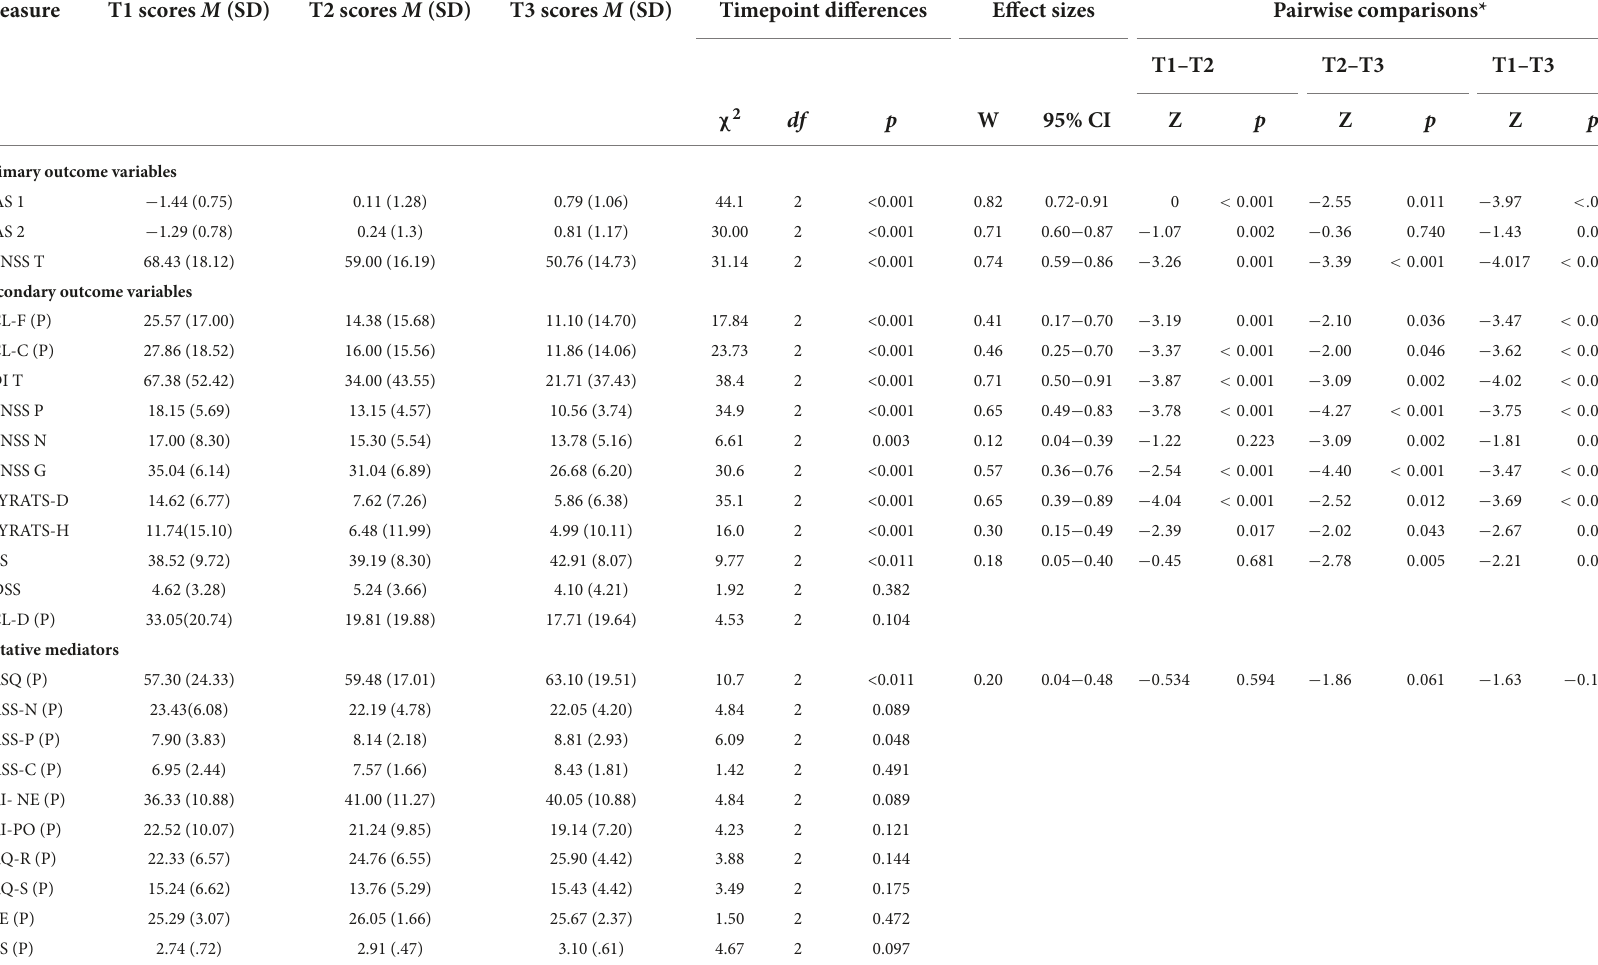
TABLE 2 Change in primary and main secondary outcome variables and putative mediators between pre-, post- and follow-up assessments (multiple imputation sample; n = 27).